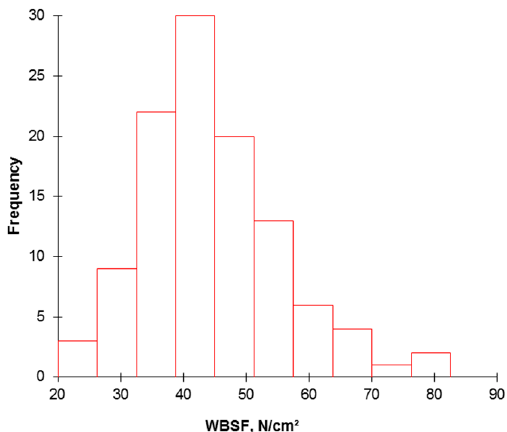
Figure 2. Histogram highlighting the relative frequency for meat tenderness assessed by WBSF on the 110 PDO Maine-Anjou cows.